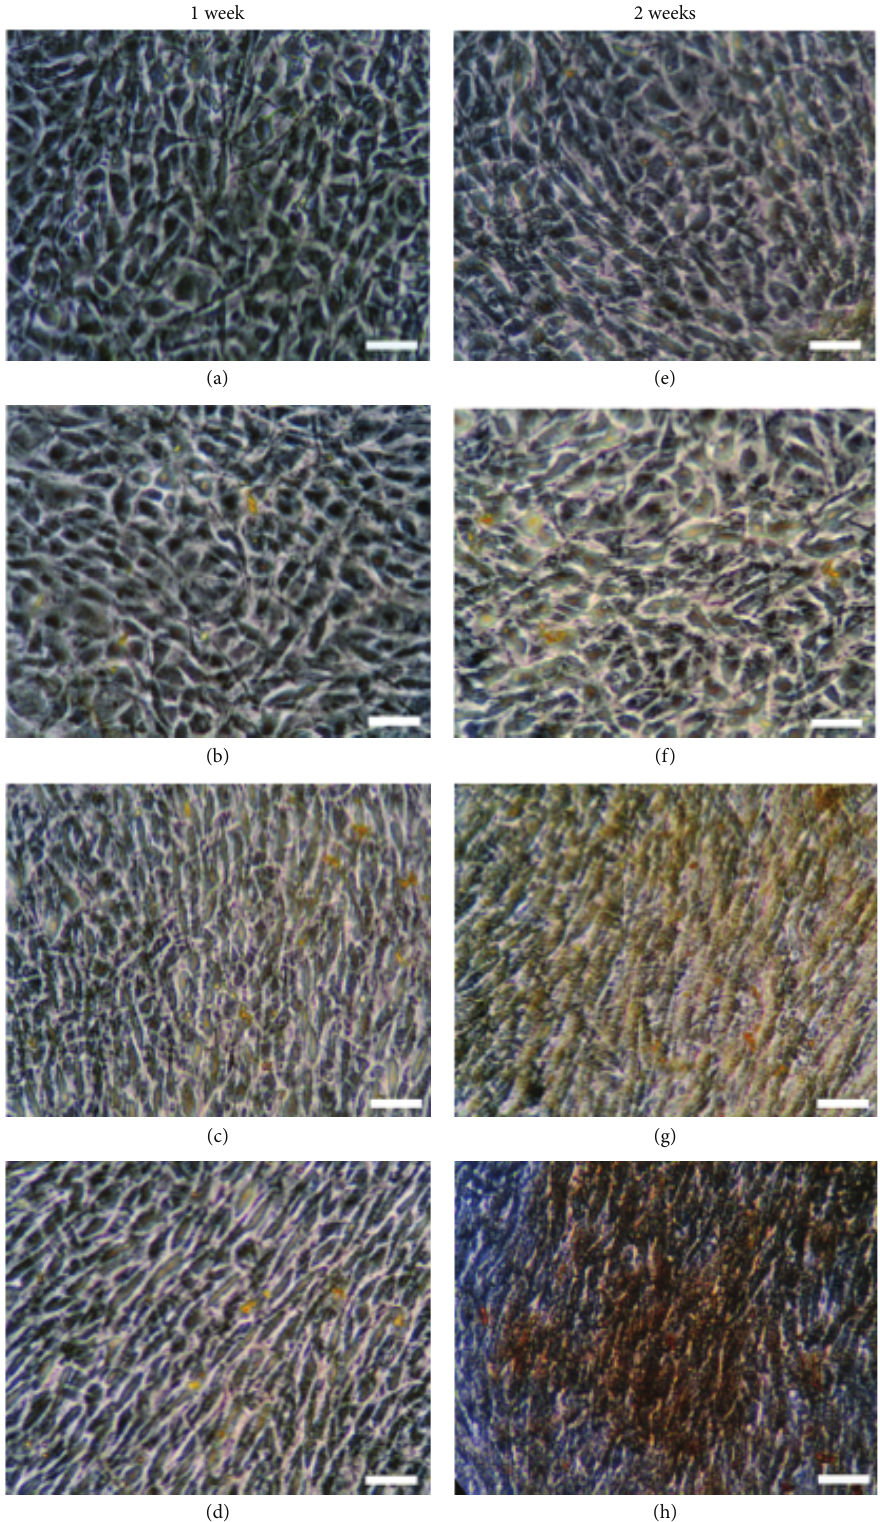
Figure 2: Representative ALP staining photographs after one or two weeks of culture: (a, e) FC-negative group, (b, f) FC-positive group, (c, g) FC-negative and BGP-positive group, and (d, h) FC-positive and BGP-positive group. ALP staining shows either a yellow or brown color. Although the typical pavement-like shape is observed at (a), (e), and (b), (f), on the whole, the cell morphology changes to a spindle-like cell shape (c, g, and d, h). Scale bar = 15 𝜇